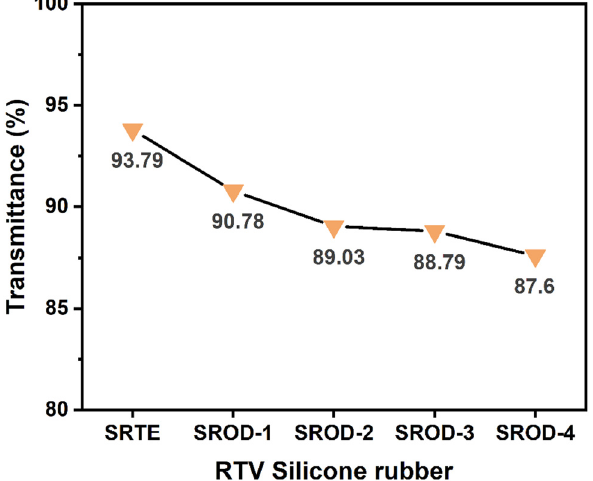
Figure 5: Optical transmittance image of RTV silicone rubbers ( SRTE, SROD - 1, SROD - 2, SROD - 3, SROD - 4 )